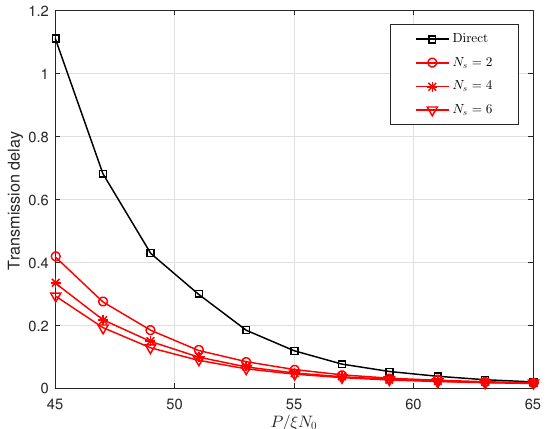
Figure 11. The transmission delay versus P / ( ξ N 0 ) with optimal power allocation and optimal relay